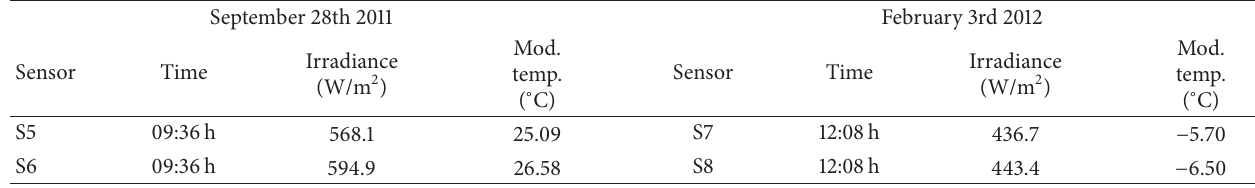
Table 4: Environmental conditions of the PV strings on September 28th, 2011, measured with sensors S5 and S6 located at both ends of String 4, and on February 3rd, 2012, measured with sensors S7 and S8 located at both ends of String 5 at the moments when the curves in Figure 12 were measured.